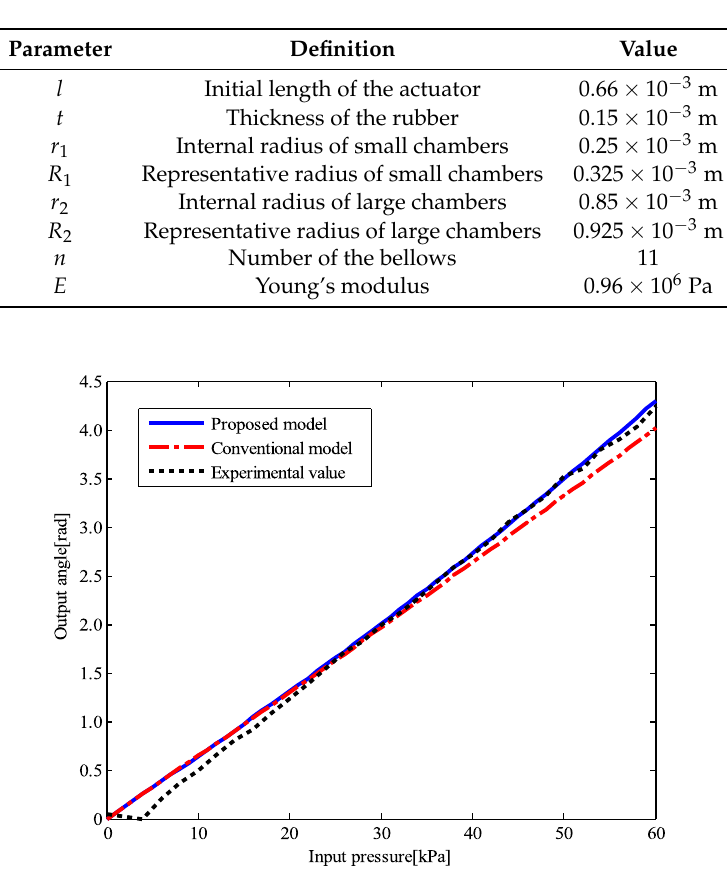
Table 1. The parameters of the actuator.